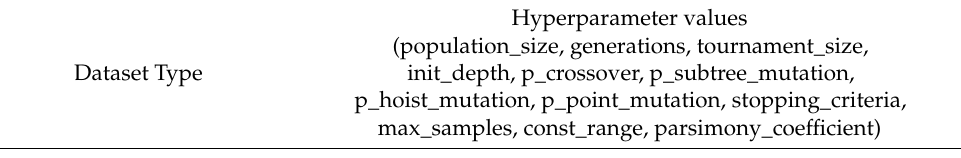
Table 8. The GP symbolic classifier hyperparameters used in each dataset variation to obtain high classification